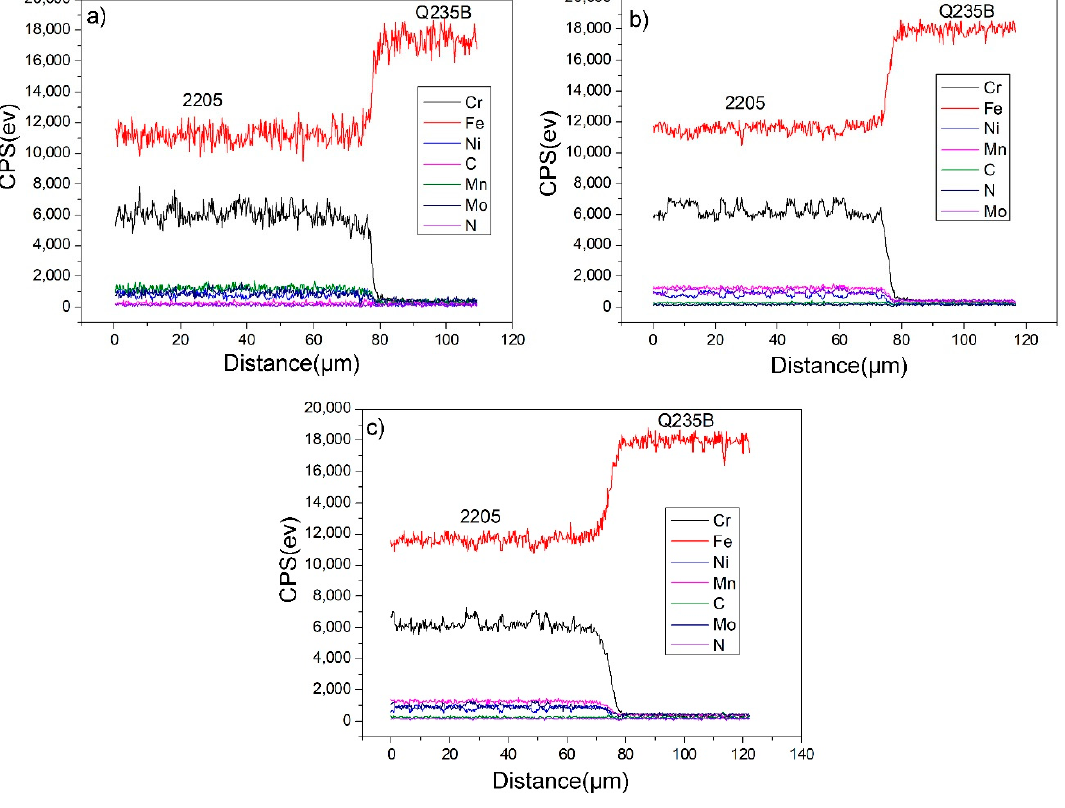
Figure 6. EDS test results of the 2205/Q235B composite steel plate binding zone: ( a ) 1,100 °C, ( b ) 1,150 °C, and ( c ) 1,200 °C.